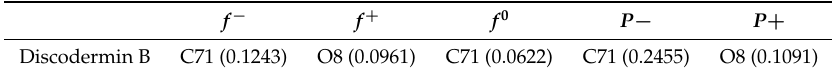
Figure A1. Graphical sketches of the local reactivity descriptors for Discodermin A showing the reactivity regions: ( a ) Electrophilic Fukui Function f − , ( b ) Nucleophilic Fukui Function f + , ( c ) Radical Fukui Function f 0 , ( d ) Electrophilic Parr Function P − and ( e ) Nucleophilic Parr Function P + . Table A2. Condensed local reactivity descriptors for Discodermin B denoting the reactivity sites: Electrophilic Fukui Function f − , Nucleophilic Fukui Function f + , Radical Fukui Function f 0 , Electrophilic Parr Function P − and Nucleophilic Parr Function P +